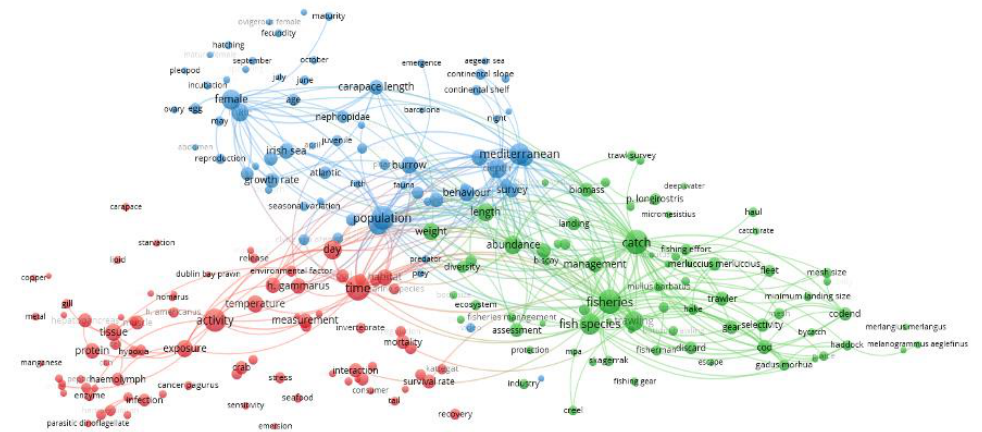
Figure 2. The term clustering map based on the analysis of publications concerned with N. norvegicus retrieved from SCOPUS database from the period 1965 – 2022. Red, blue, and green colors represent the terms belonging to different clusters. The dot size of each term is based on the number of its occurrence. The connecting lines indicate the 300 strongest co-occurrence links between terms.